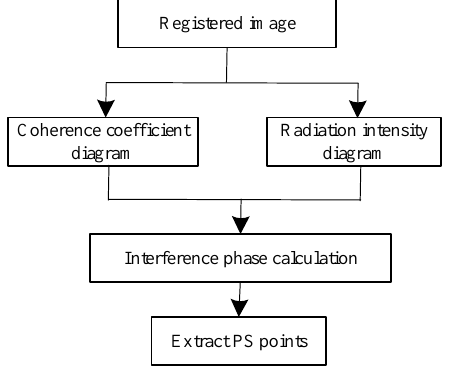
Figure 3. Technical flow chart of PS point selection